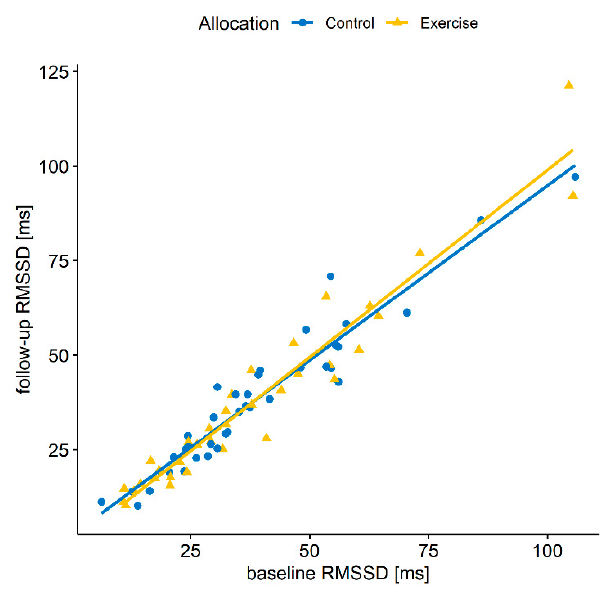
Figure 2. Baseline and follow-up RMSSD by allocation.